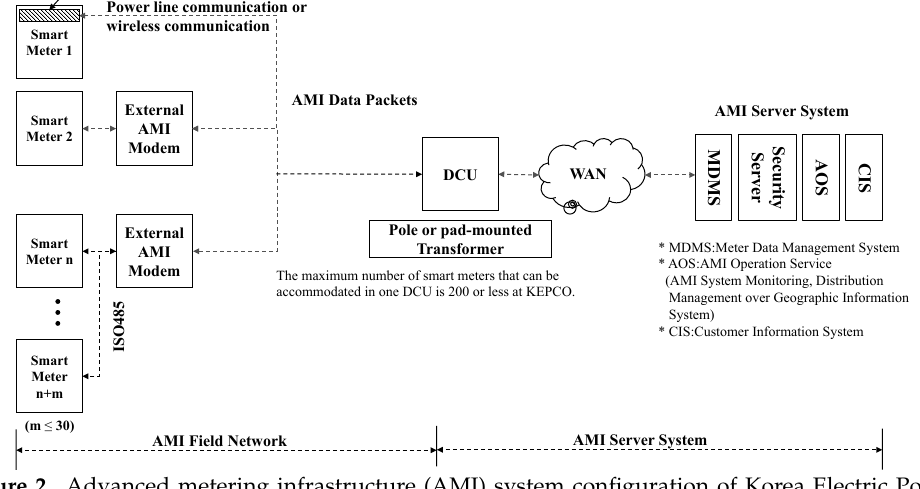
Figure 2. Advanced metering infrastructure (AMI) system configuration of Korea Electric Power Corporation (KEPCO), Republic of